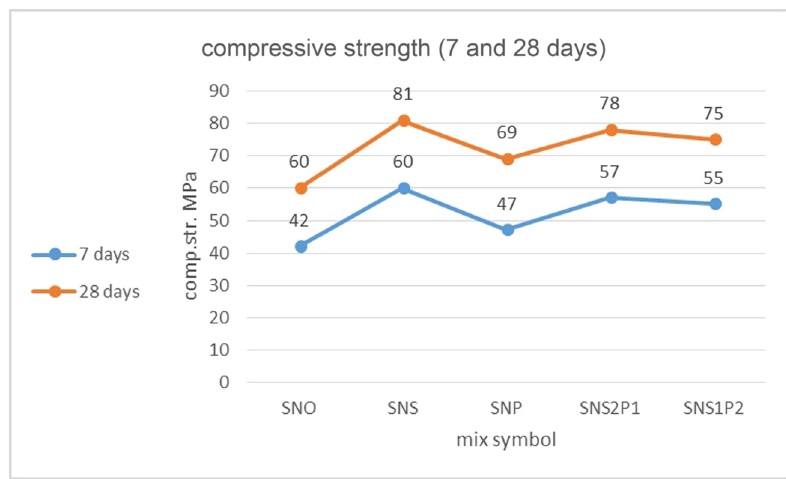
Figure 3: Compressive strength results.